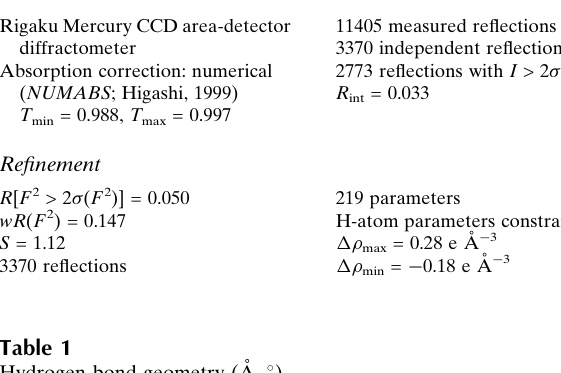
Hydrogen-bond geometry (A˚ , (cid:1)